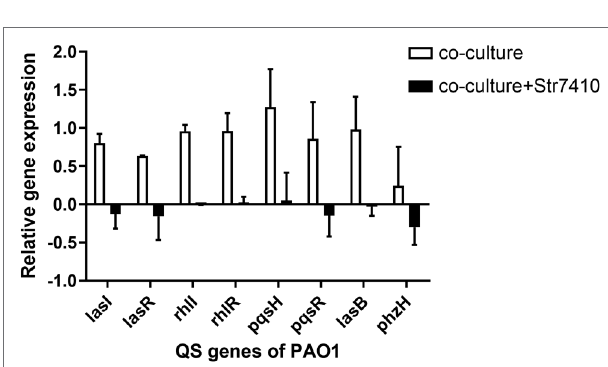
FIGURE 7 | Expression on quorum sensing (QS) and virulence factor-related genes of Pseudomonas aeruginosa PAO1 when strain PAO1 was co-cultured with Staphylococcus aureus ATCC 25923 compared with PAO1 monoculture, and the effect of compound Str7410 (40 μ M) on the expression of PAO1 QS and virulence factor-related genes in co-culture. Values are presented as the mean ± SD ( n =